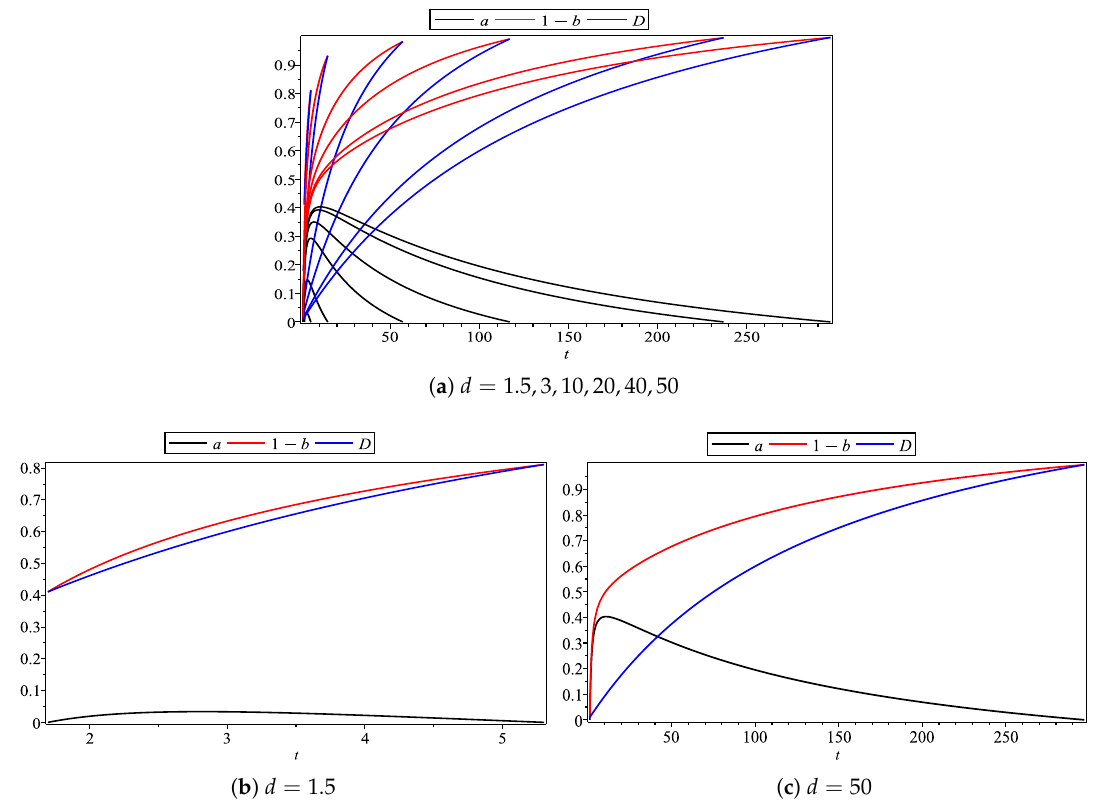
Figure 2. Subjective effect of CEA on the products’ environmental quality